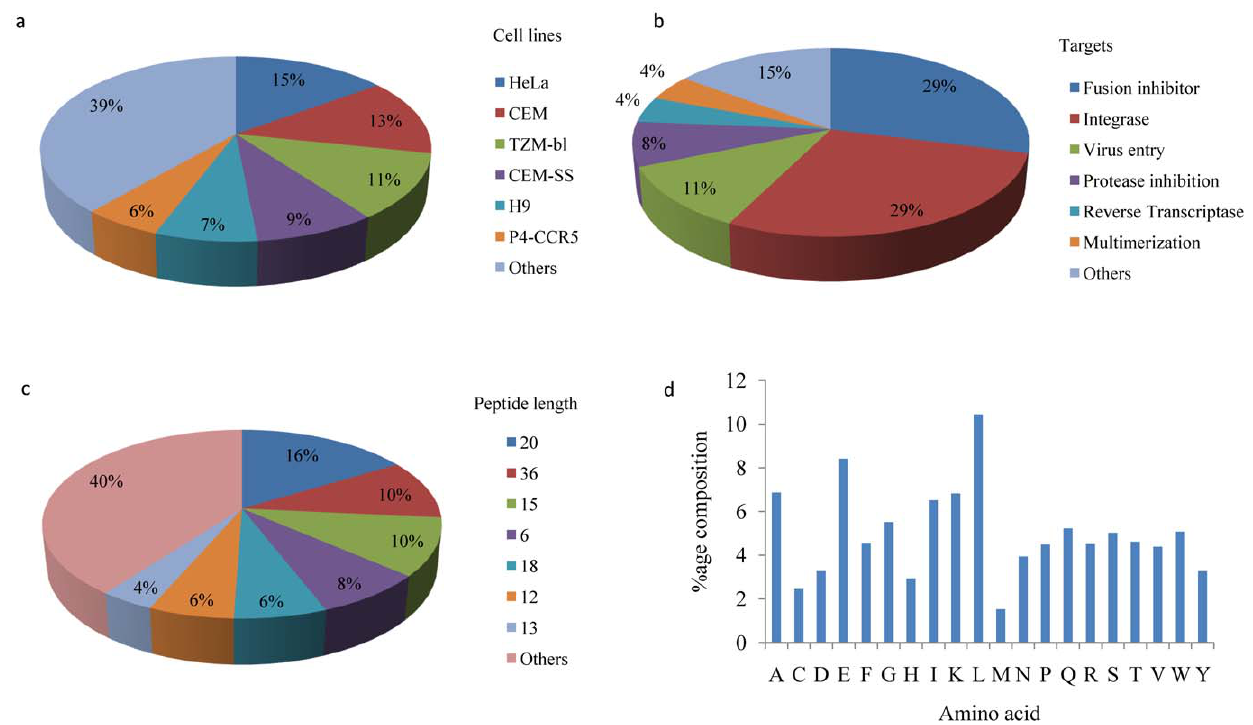
Figure 2. HIPdb statistics: a) Targets, b) Cell lines, c) Peptide length, d) Amino acid composition.